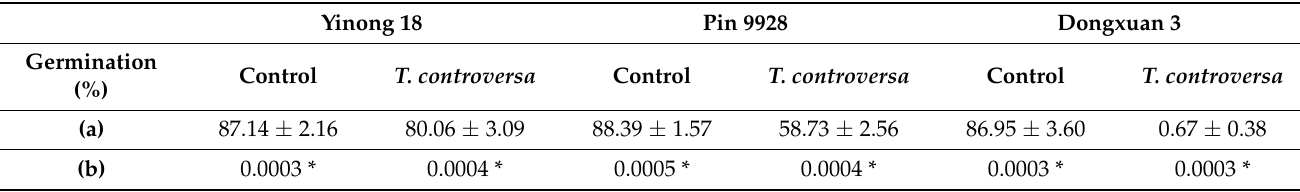
Table 1. ( a ) Germination (%) of wheat pollen in control and under T. controversa infection in resistance (Yinong 18), moderately resistance (Pin 9928) and susceptible (Dongxuan 3) wheat cultivars; ( b ). t -test of germination (%) of wheat pollen